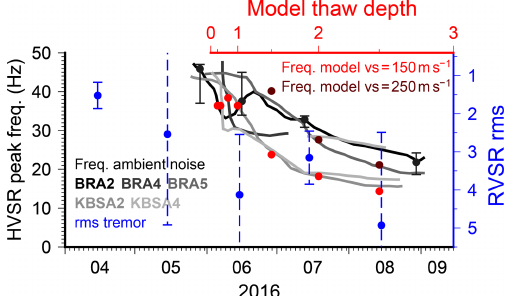
Figure 8. Effect of permafrost active layer on HVSR measure- ments. Comparison of observed ambient noise HVSR peak frequen- cies for stations BRA2, BRA4, BRA5, KBSA2, and KBSA4 (solid lines) and modeled peak frequencies (red symbols) taking into ac- count anti-aliasing filter of seismic instrument. For station BRA2, additional black symbols and error bars show peak frequencies and uncertainties corresponding to days in Fig. 4d. For the x axis on top representing modeled thaw depth, we assume a square root de- pendency with time from the beginning of June. Tremor RVSR rms values from Fig. 7 are shown. The rms and peak frequencies follow a similar